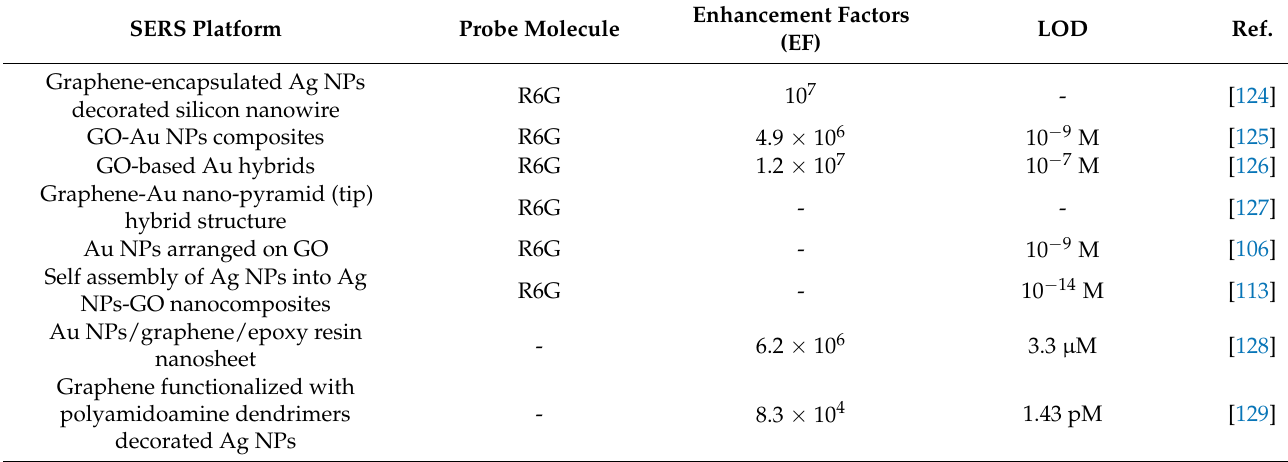
Table 7. A summary of selected papers regarding the graphene-based Surface-Enhanced Raman Scattering (SERS) biosensor. SERS